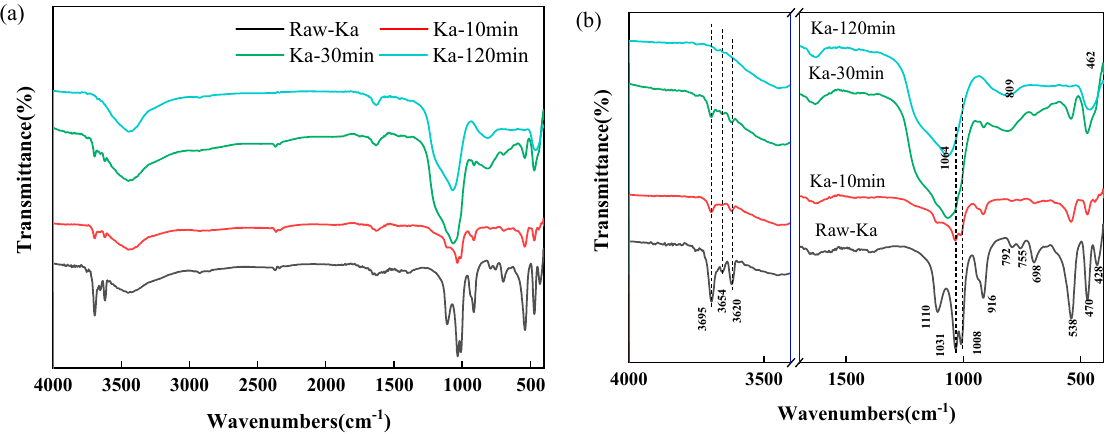
Figure 2. ( a ) FTIR spectra of Raw − Ka, Ka − 10 min, Ka − 30 min, Ka − 120 min; ( b ) local amplification of FTIR spectra of Raw − Ka, Ka − 10 min, Ka − 30 min, Ka − 120 min in range of wavenumbers = 400 − 1700 cm − 1 and 3400 − 4000 cm − 1 .